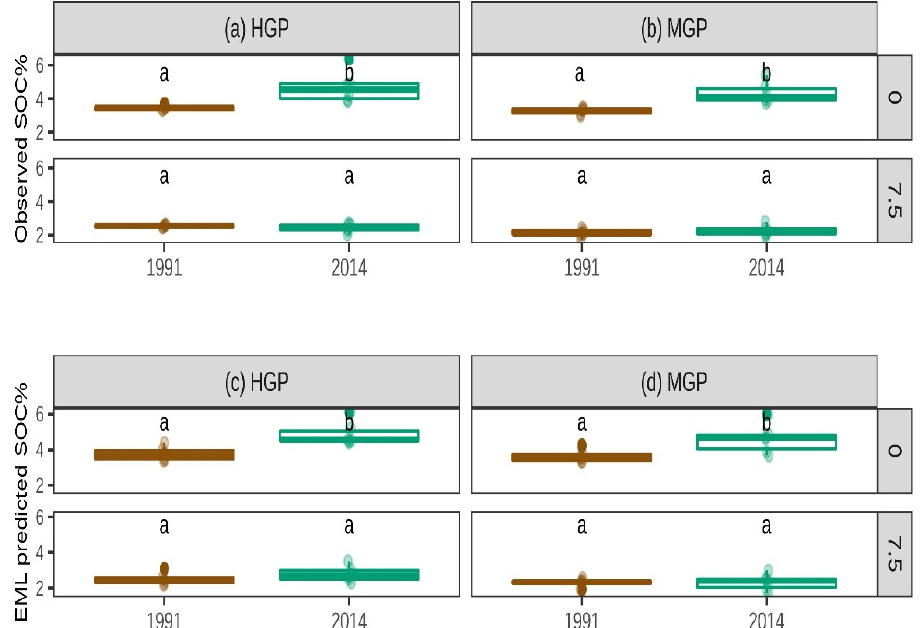
Figure 6. Boxplot of observed and EML-predicted %SOC for the Mandan trials across years and depths (0–7.5 cm and 7.5–15 cm, n=6 per depth). ( a , b ) are observed SOC% for high and moderate grazed management. ( c , d ) are EML-predicted SOC% for high and moderate grazed management practices. No significant difference between the same letters. Significance level <0.05.